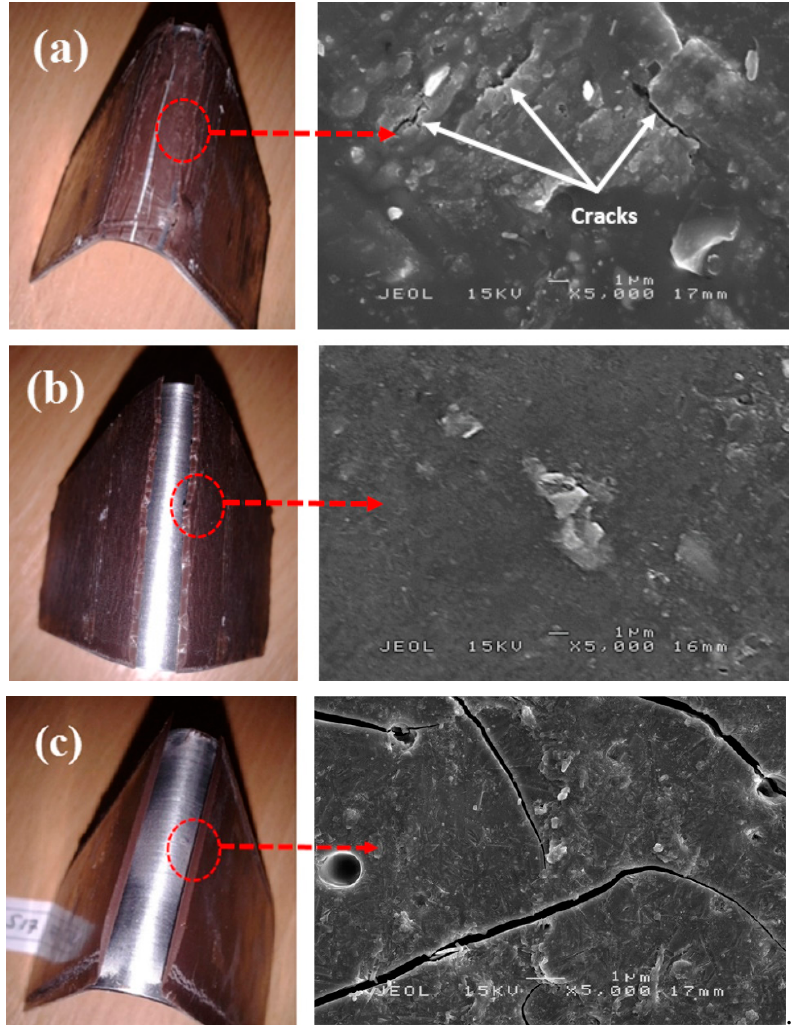
Figure 12. Image and SEM micrograph of samples following the flexural test ( a ) S13; ( b ) S14; and ( c ) S17.